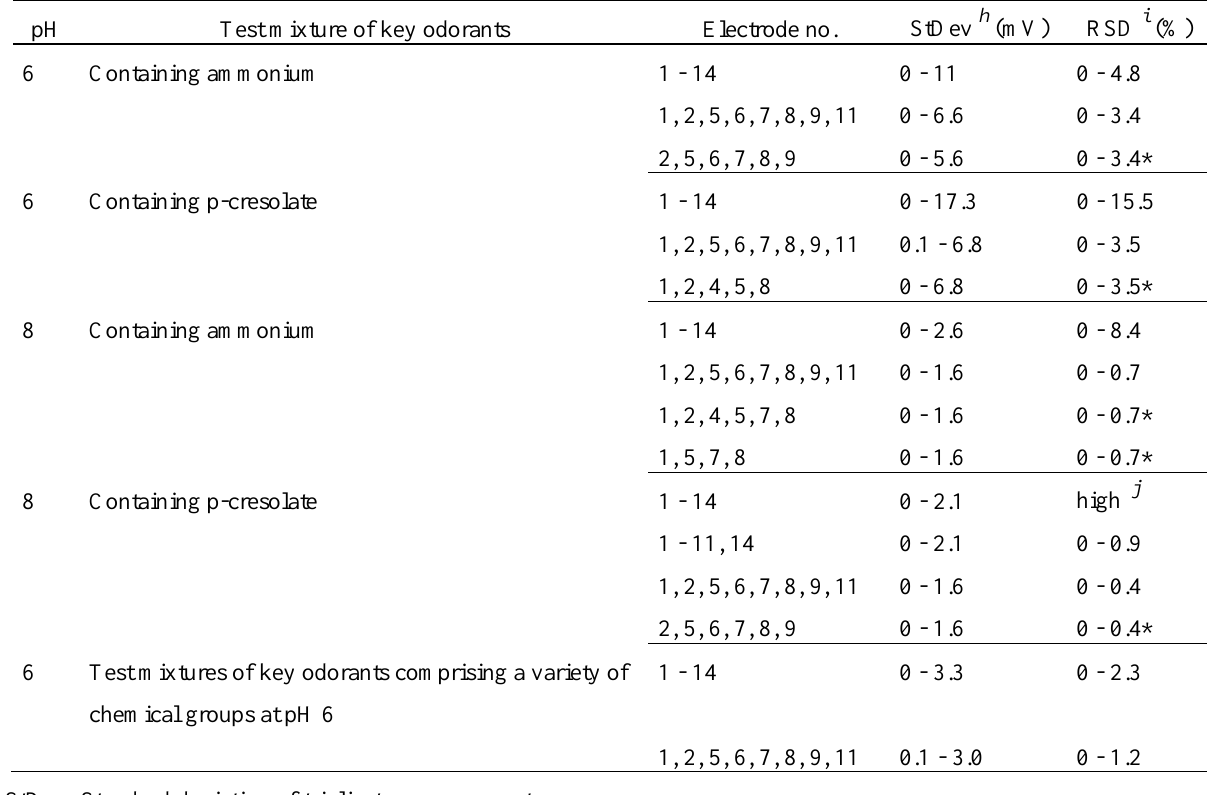
Table 4. Standard deviation (StDev) and relative standard deviation (RSD) of triplicate measurements with different number of electrodes used for classification and calibration. pH Test mixture of key odorants Electrode